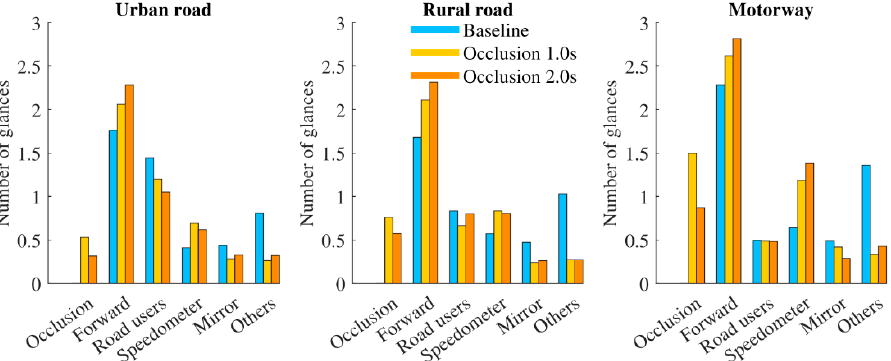
Figure 5. The number of glances towards each AOIs before eyes-off-road per road type and occlusion duration.